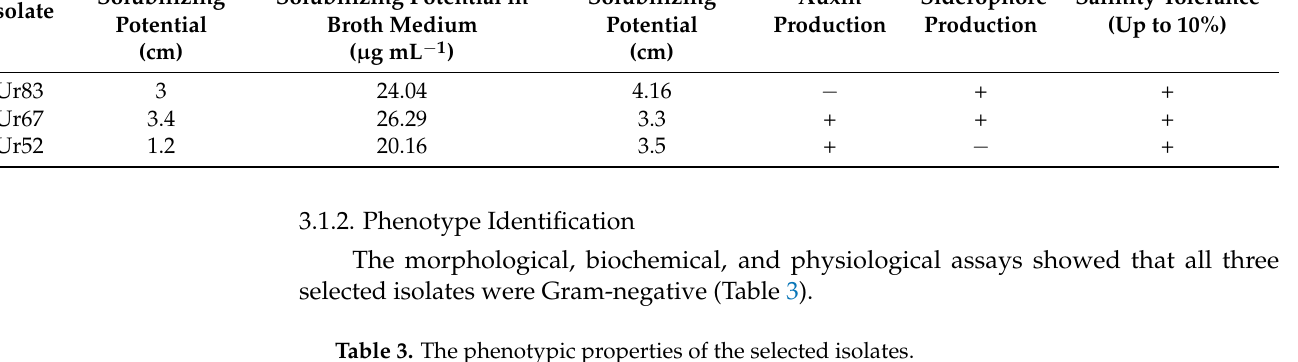
Table 3. The phenotypic properties of the selected